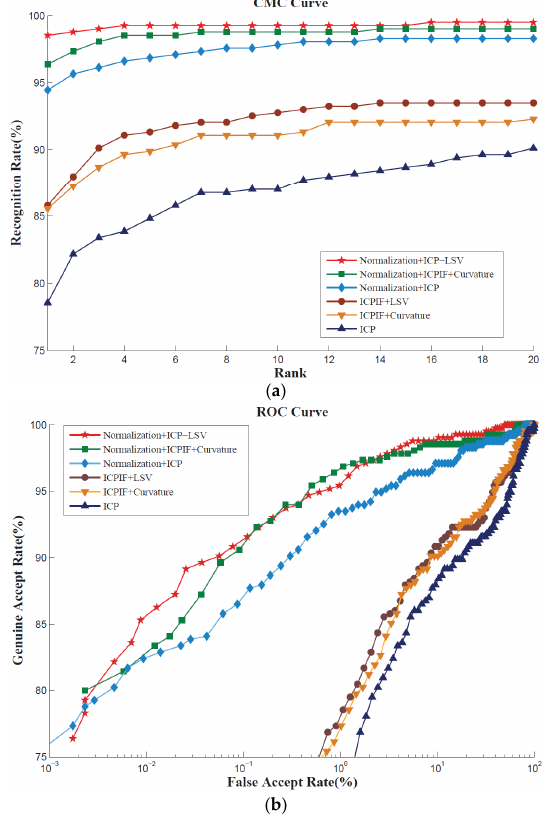
Figure 14. Comparing recognition performance of different algorithms: ( a ) The Cumulative Matching Characteristics (CMC) curves; ( b ) The Receiver Operating Characteristic (ROC) curves.